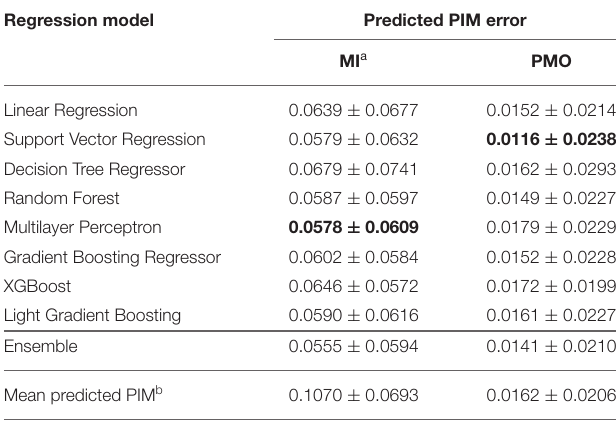
TABLE 3 | Prediction error of regression models for the PIM quantification.